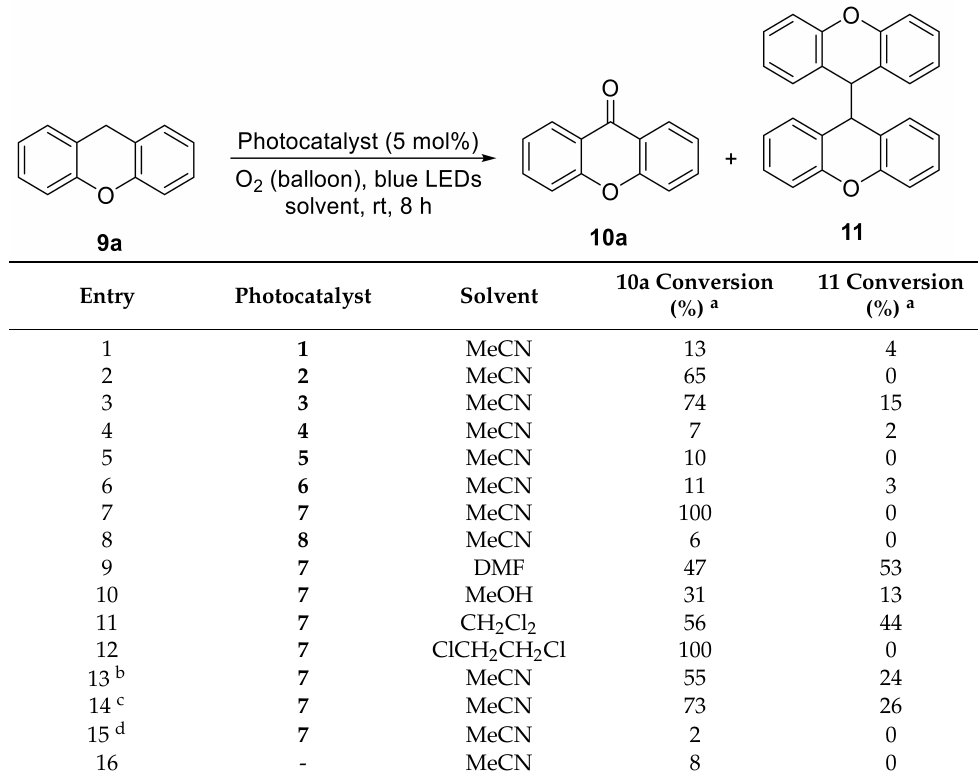
Table 1. Screening and optimization of the reaction conditions for the photo-oxidation of 9 H